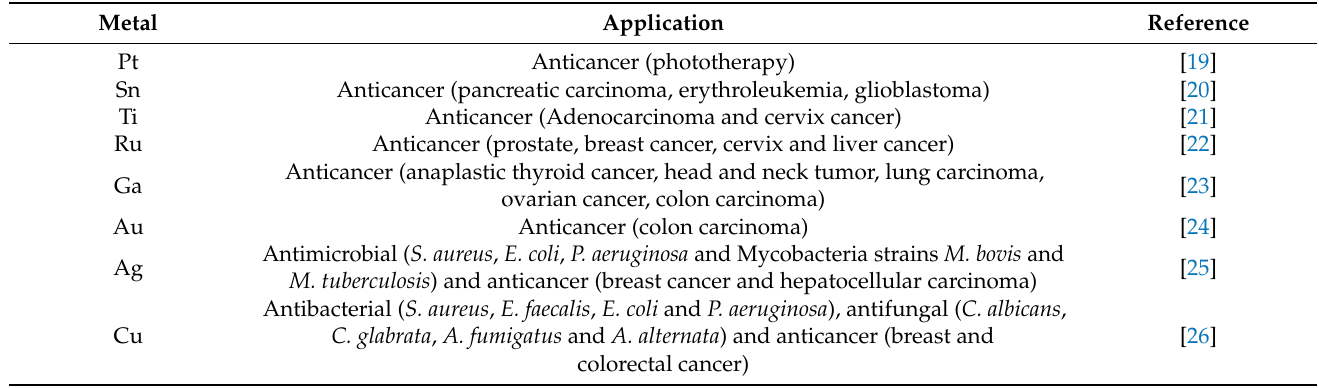
Table 1. Principal metals used in anticancer and antibacterial applications highlighting references with significant contribution of Spanish